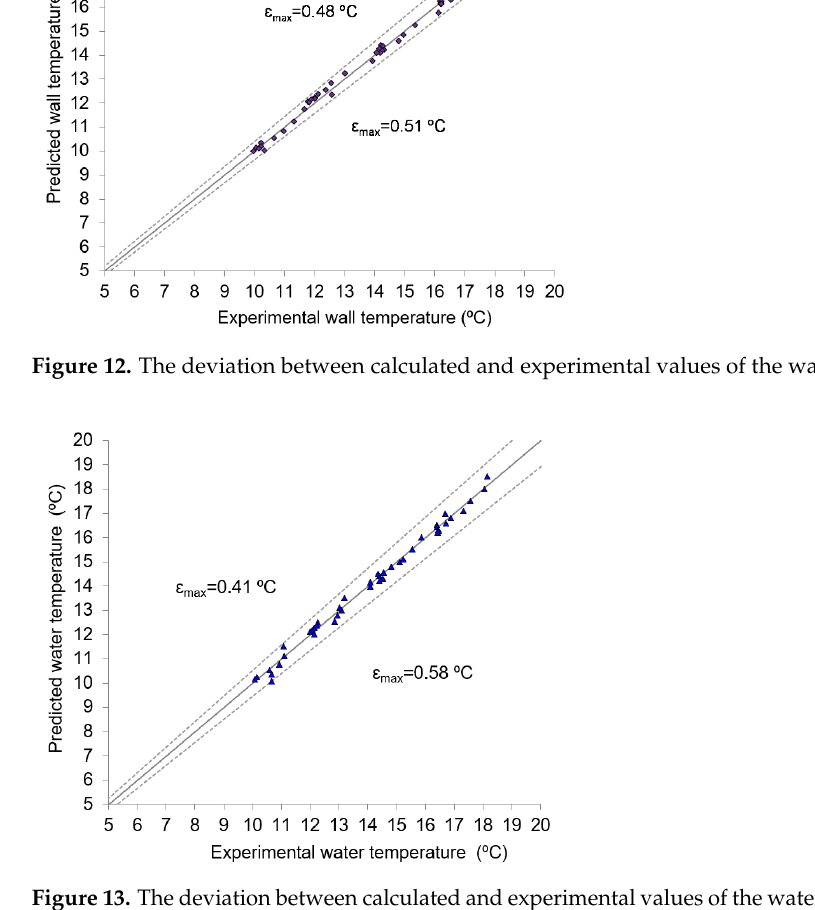
Figure 13. The deviation between calculated and experimental values of the water outlet tempera- ture.